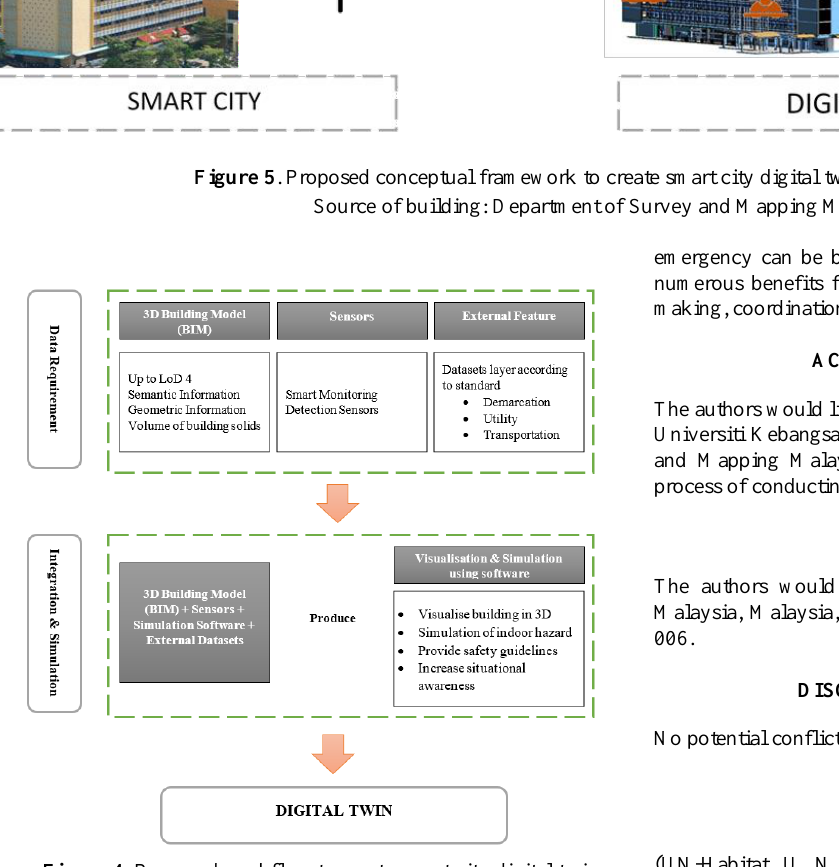
Figure 4 . Proposed workflow to create smart city digital twin for indoor hazard.